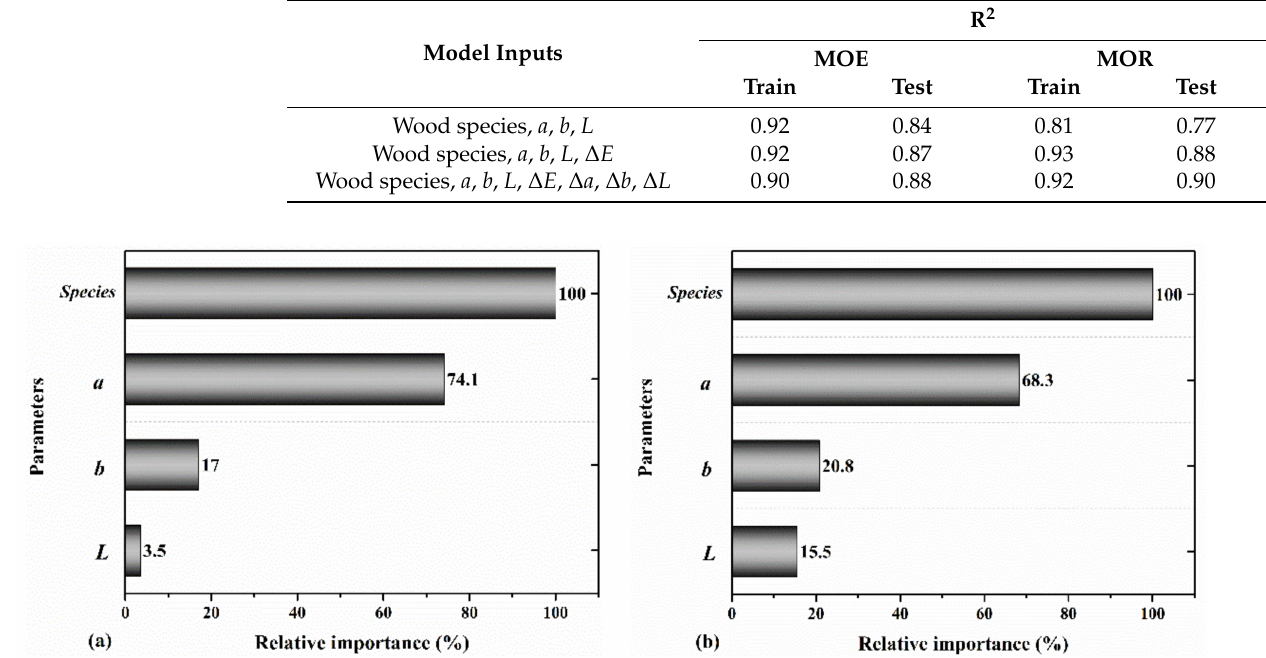
Figure 9. The relative importance of the wood species, a, b , and L for predicting the ( a ) MOE and ( b ) MOR. Table 2 shows that adding the total color change ∆ (E) parameter as an input to the model improved the prediction accuracy. In this case, the MOE and MOR were predicted with an R 2 of 0.87 and 0.88, respectively (test data). Figure 10 shows the relative importance of the parameters used in this model. It was indicated that all of the input parameters were important in the performance of the model, while the total color change had relatively